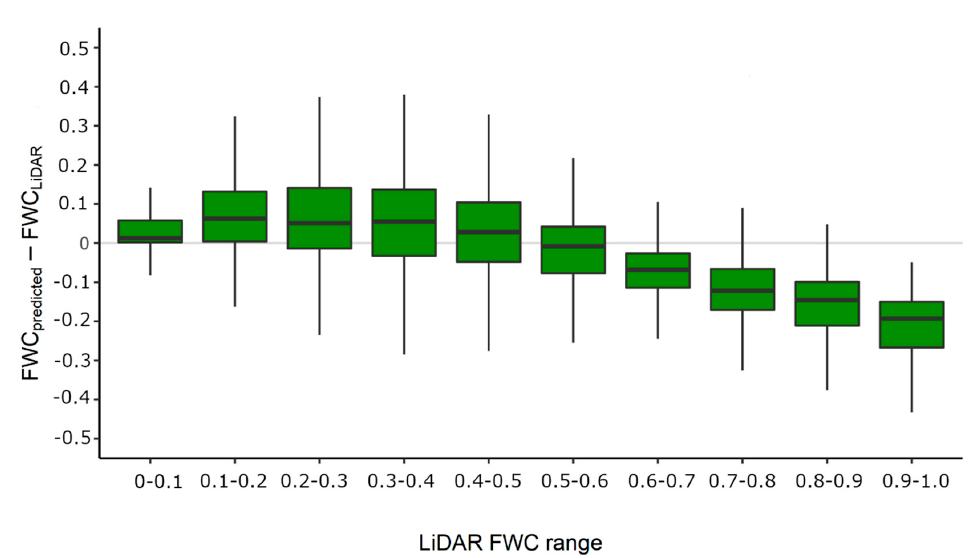
Figure 6. Di ff erence between predicted FWC and LiDAR FWC per LiDAR FWC bin for 50 m resolution Figure 6. Difference between predicted FWC and LiDAR FWC per LiDAR FWC bin for 50 m FWC maps (example for FWC2009 50mSAR + elev + MAP ). Median, box: 25th and 75th percentiles = resolution FWC maps (example for FWC2009 50mSAR+elev+MAP ). Median, box: 25th and 75th percentiles = interquartile range (IQR), whiskers: quartile ± interquartile range (IQR), whiskers: quartile ±1.5*IQR.